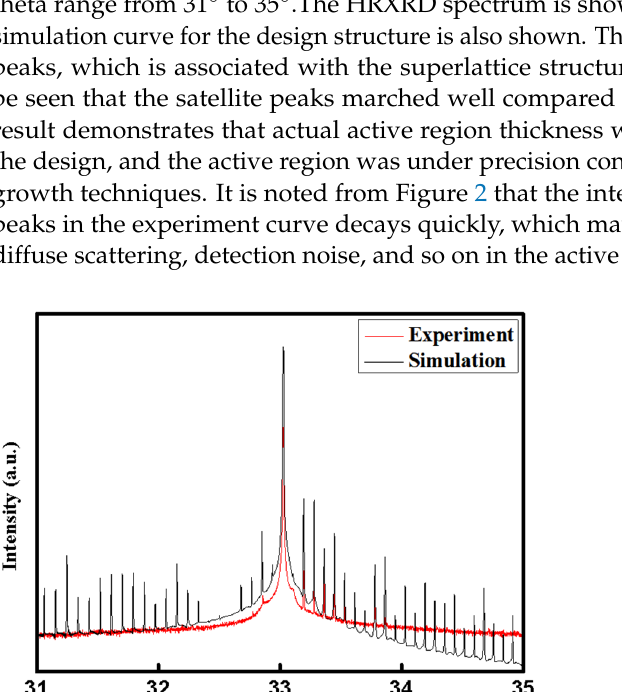
Figure 1. High resolution XRD spectrum and theoretical simulation curve of the wafer.